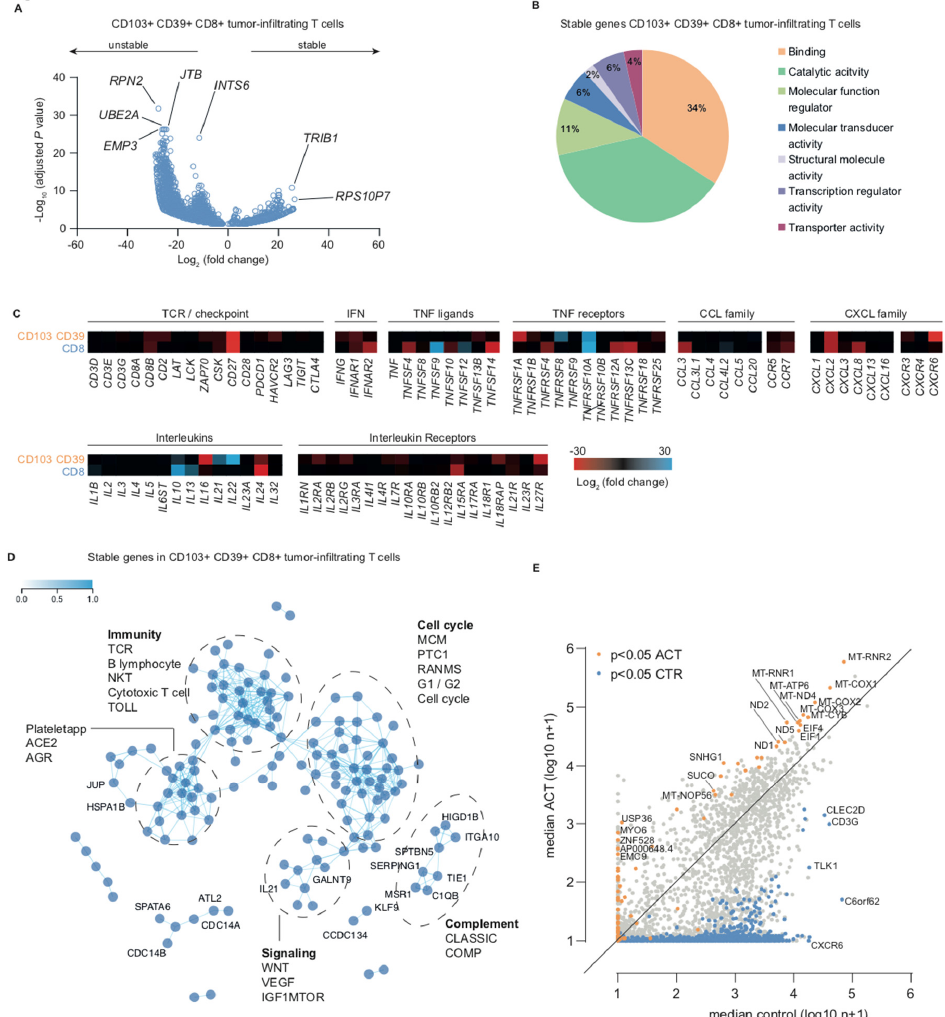
Figure 2. E ff ect of actinomycin D on transcriptional activity of CD39 + CD103 + T RM . ( A ) Volcano Figure 2. Effect of actinomycin D on transcriptional activity of CD39+CD103+ T RM . ( A ) Volcano plot depicting differentially expressed genes (DEseq2) of CD39+CD103+ T RM cells treated with actinomycin